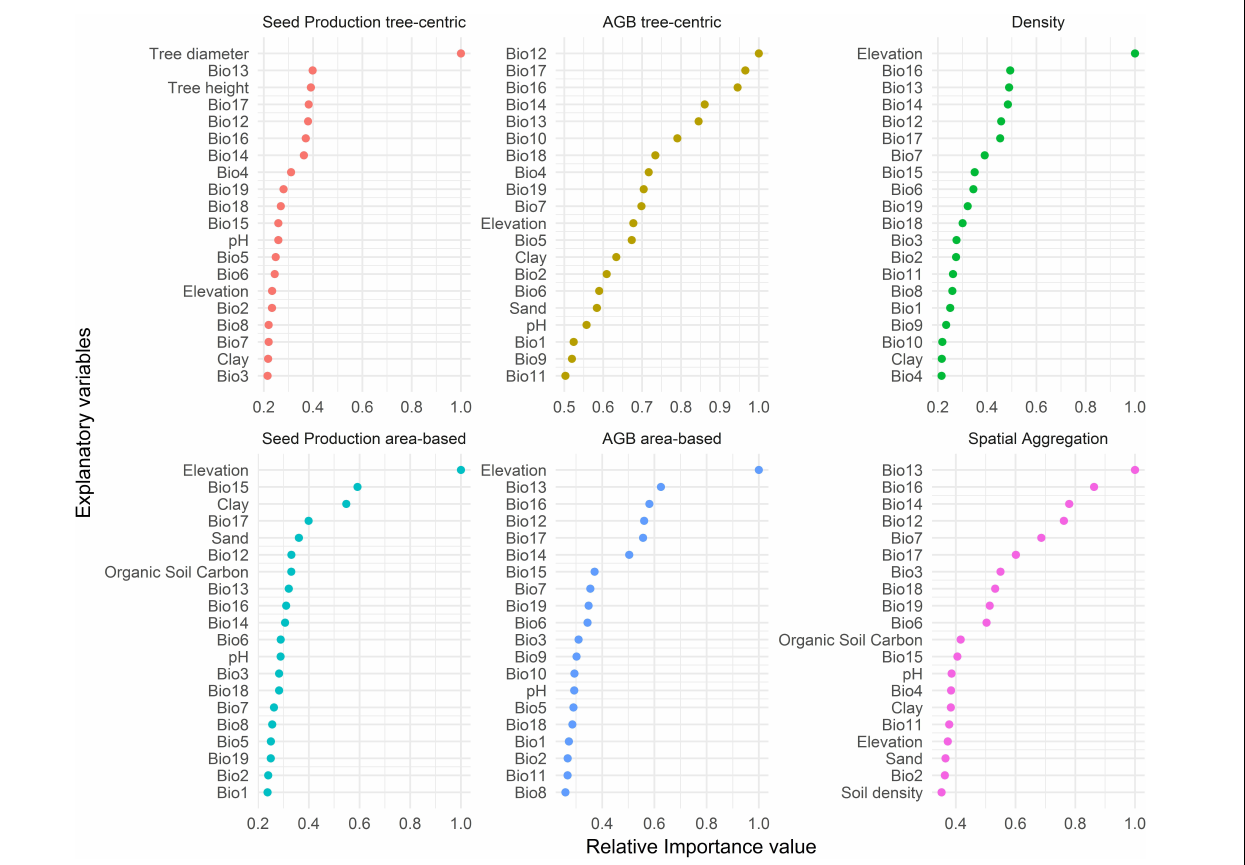
FIGURE 4 | Relative importance values of the 15 most important variables for explaining variation in the six response variables. Bio1–11 correspond to temperature-related variables; Bio12–19 to precipitation-related variables. Bio1, annual mean temperature; Bio2, mean diurnal range; Bio3, isothermality (Bio2/Bio7) (100 × ); Bio4, temperature seasonality; Bio5, max temperature of warmest month; Bio6, min temperature of coldest month; Bio7, temperature annual range (Bio5–Bio6); Bio8, mean temperature of the wettest quarter; Bio9, mean temperature of the driest quarter; Bio10, mean temperature of the warmest quarter; Bio11, mean temperature of the coldest quarter; Bio12, annual precipitation; Bio13, precipitation of the wettest month; Bio14, precipitation of the driest month; Bio15, precipitation seasonality; Bio16, precipitation of the wettest quarter; Bio17, precipitation of the driest quarter; Bio18, precipitation of the warmest quarter; Bio19, precipitation of the coldest